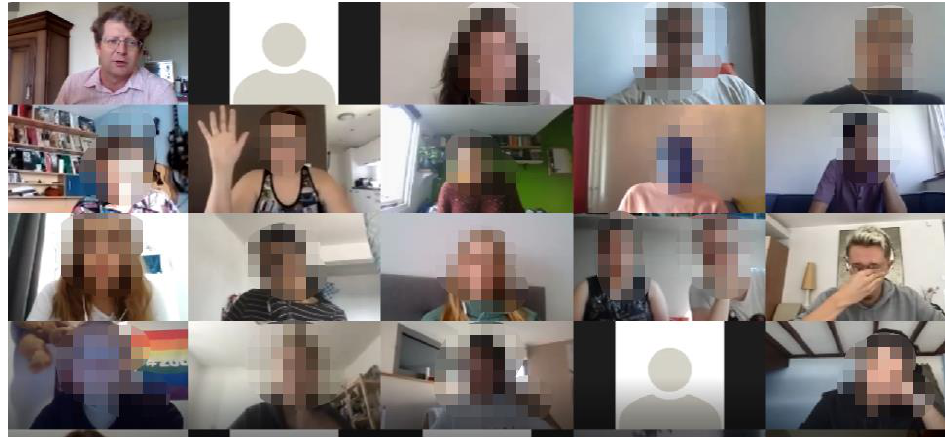
Figure 4. Visual representation of participant behaviors